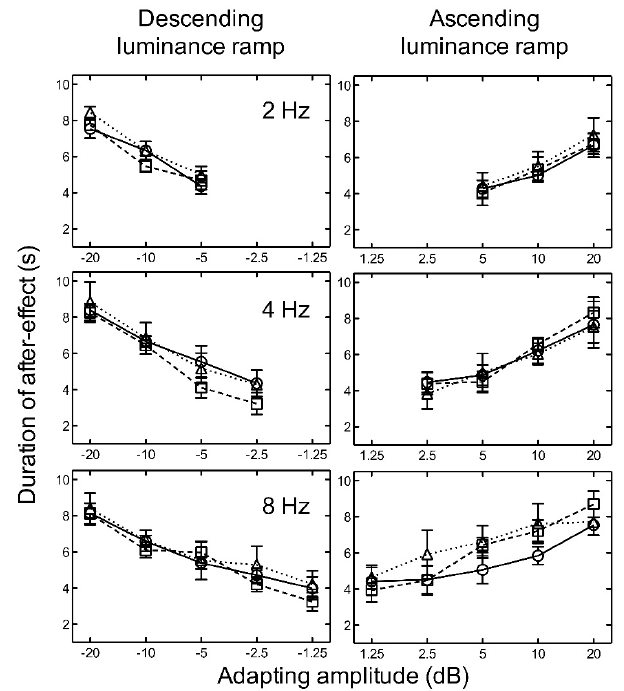
Figure 4. Experiment 2. The duration of the aftereffect is plotted as a function of adapting luminance amplitude for linear (circles/solid line) (from Experiment 1), logarithmic (squares/broken line), and exponential (triangles/dotted line) luminance ramps at 2, 4, and 8 Hz. Luminance amplitudes greater than zero represent ascending ramps and negative values represent descending ramps. Symbols represent the mean of five subjects and error bars represent ± 1